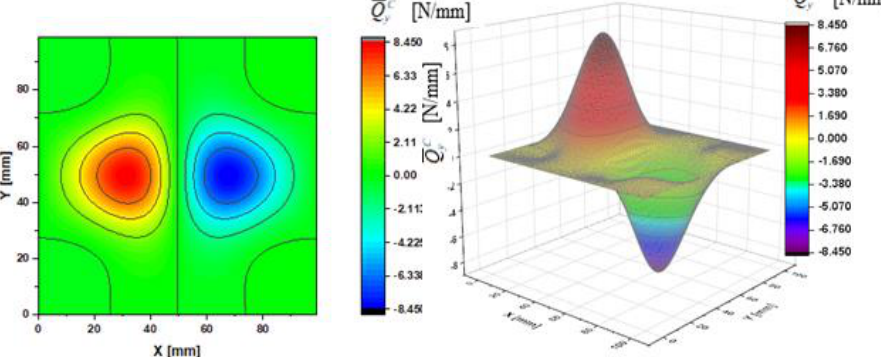
Figure 5. Contour-plane chart of C y Q for Case A.